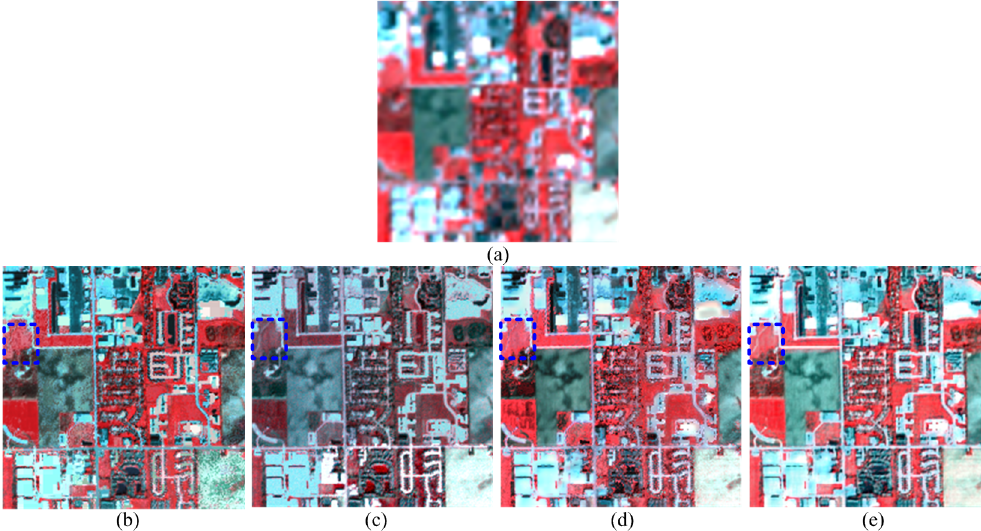
Figure 12. False color composite (bands 45, 21, 14) of the enlarged area in the yellow box of Figure 10, size of the area is 200 × 200, ( a ) the original 30 m Hyperion data; ( b ) fusion result of SSR [12]; ( c ) fusion result of BayesSR [13]; ( d ) fusion result of CNMF [6]; ( e ) fusion result of Two-CNN-Fu. Table 6. The number of ground truth labeled in the study area.